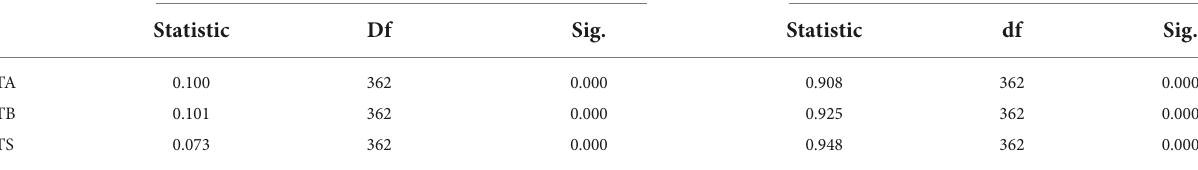
TABLE 1 Test of normality.